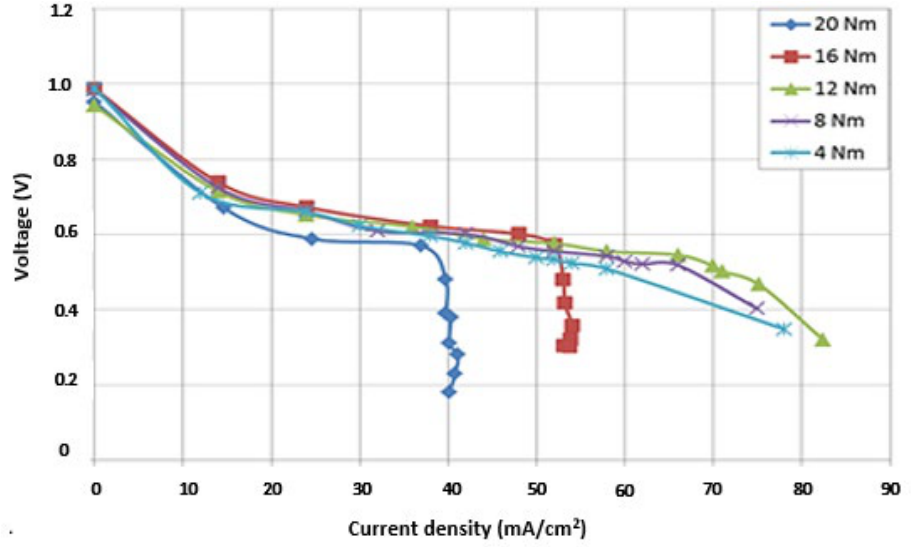
Figure 6. Polarization curves at various compression values.